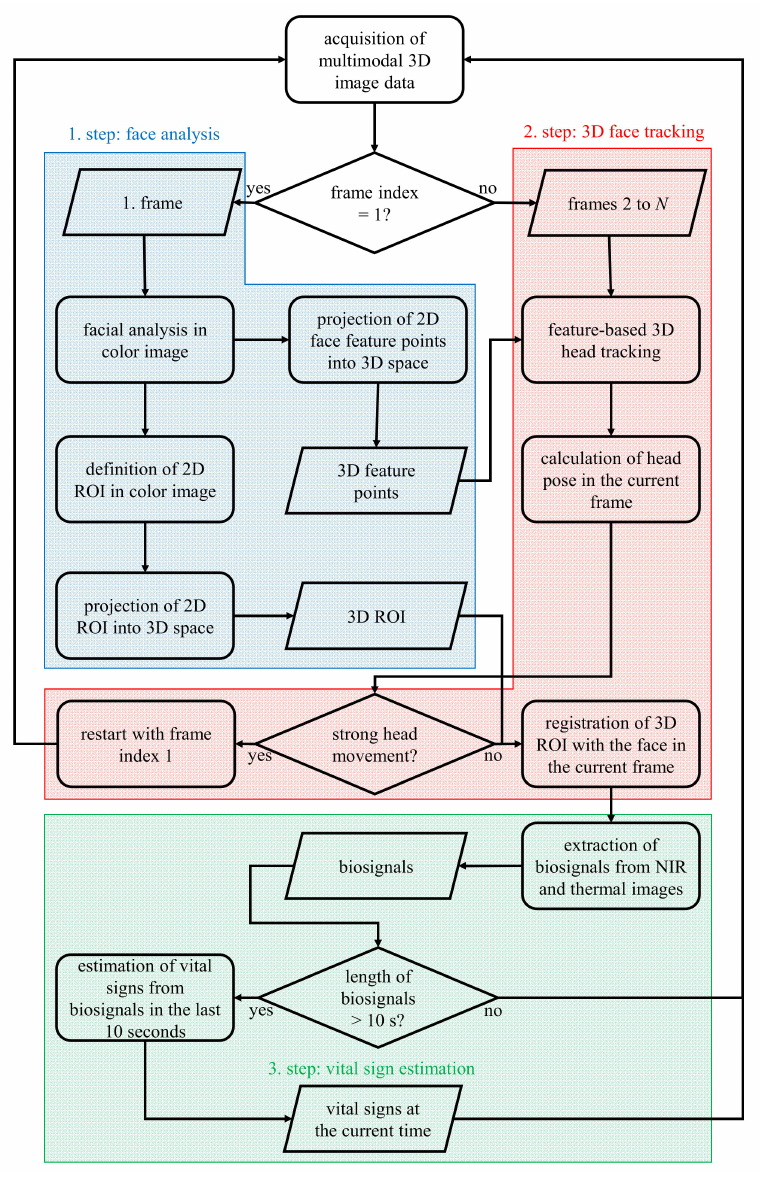
Figure 3. Procedure of vital sign estimation from multimodal video